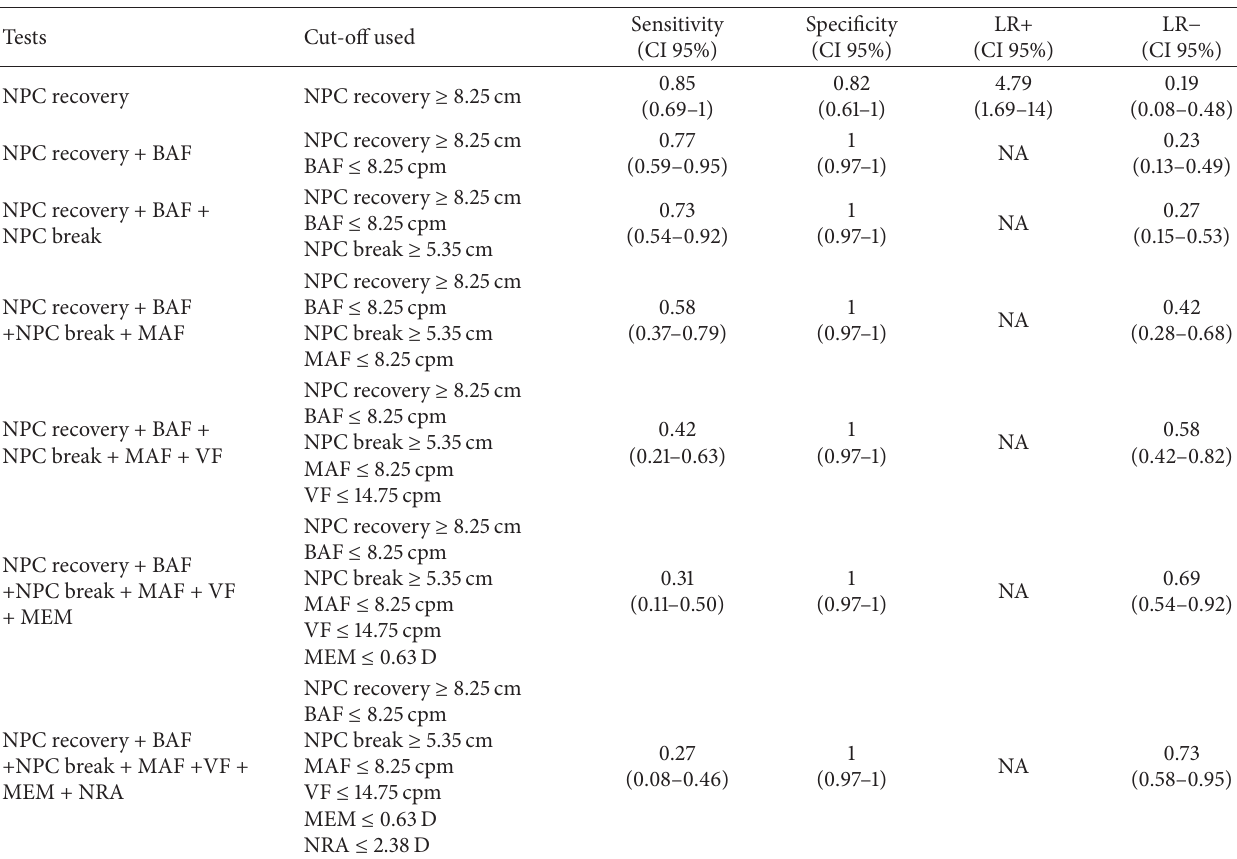
Table 5: Diagnostic validity for different test combinations using cut-offs derived from ROC